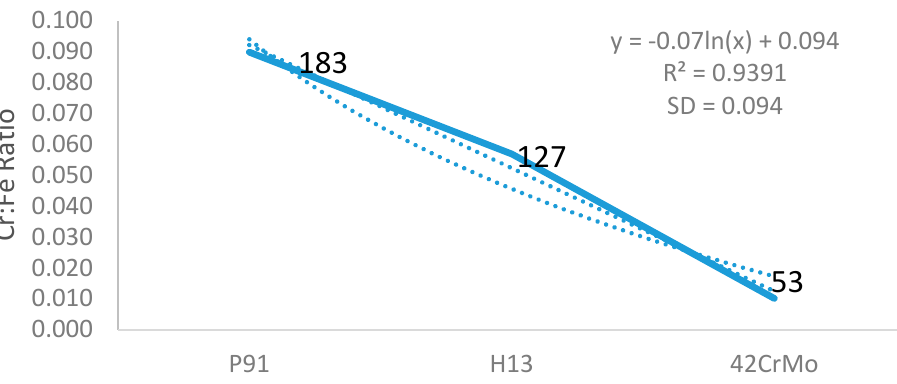
Figure 2. Correlation of Cr:Fe to mushy zone temperature.